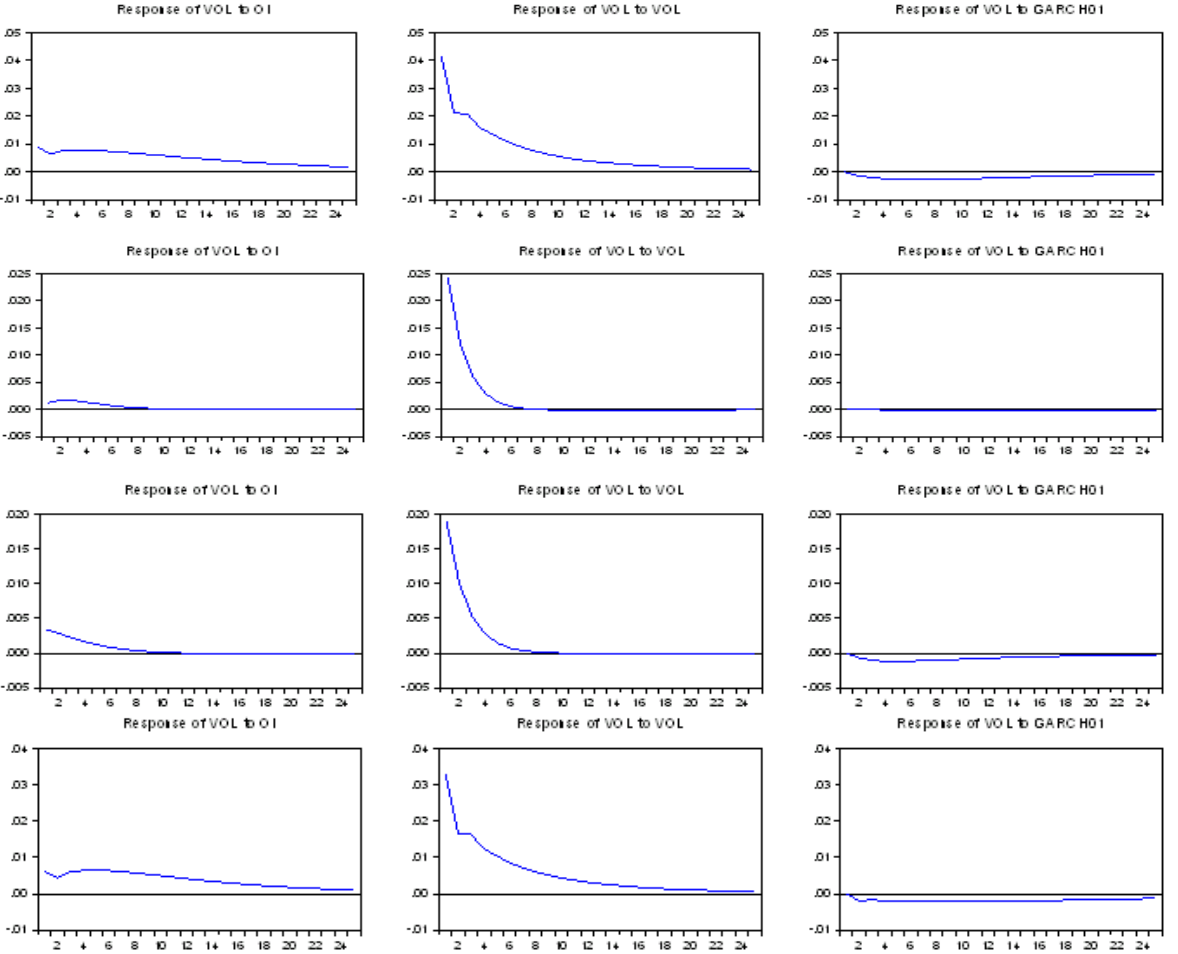
Fig. 3. Impulse response of volume to one unit positive shocks in open interest and volatility over three sub-periods for contract size starting with 200 (first row), followed by 100 (second row), 50 (third row) and finally for the full period (fourth row). First, second and third column starting from left reflect impulse response of volume to shocks of open interest, its own and volatility,